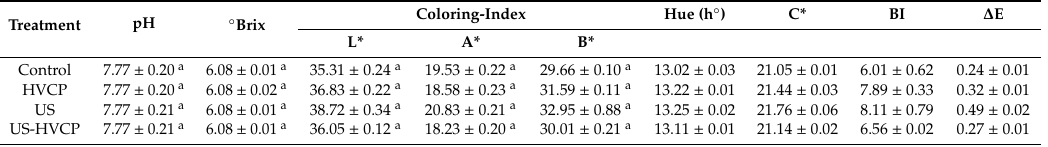
Table 4. Combined treatment e ff ect of HVCP and US on pH, ◦ Brix, and color indexes. Coloring-Index Hue (h ◦ ) C* BI ∆ E Treatment pH ◦ Brix